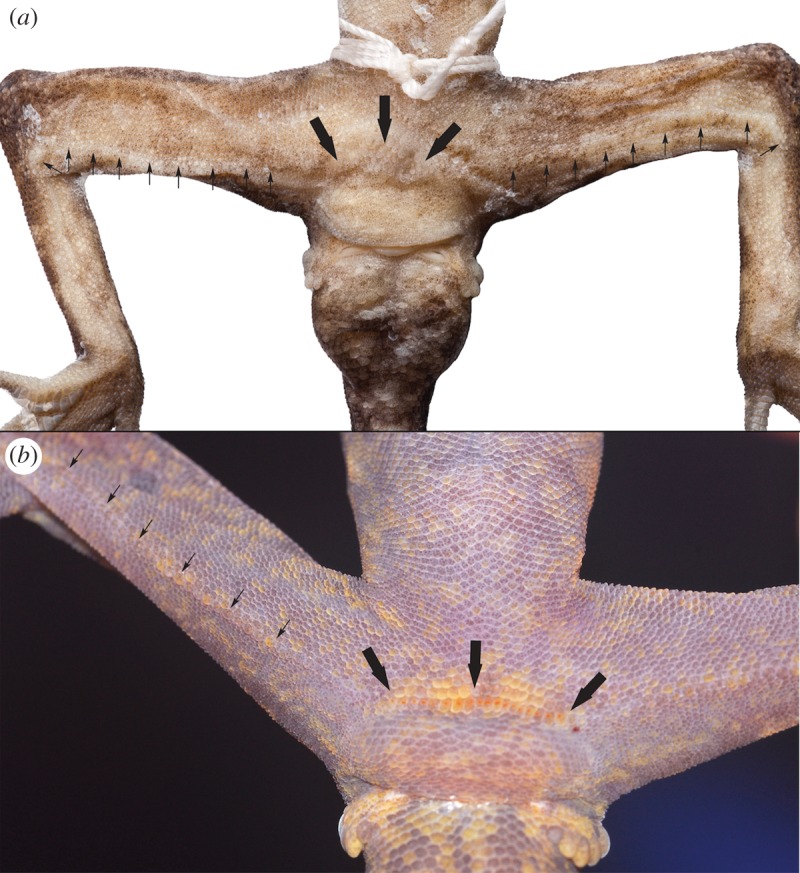
Pore series of the holotype of Cyrtodactylus tanim n. sp. NMV75956 (a), as well as a paratype NMV75962 (b) in life. Note the more visible femoral and precloacal pores in (b) and the diastema of slightly enlarged, but non pore-bearing scales between the femoral and precloacal series.